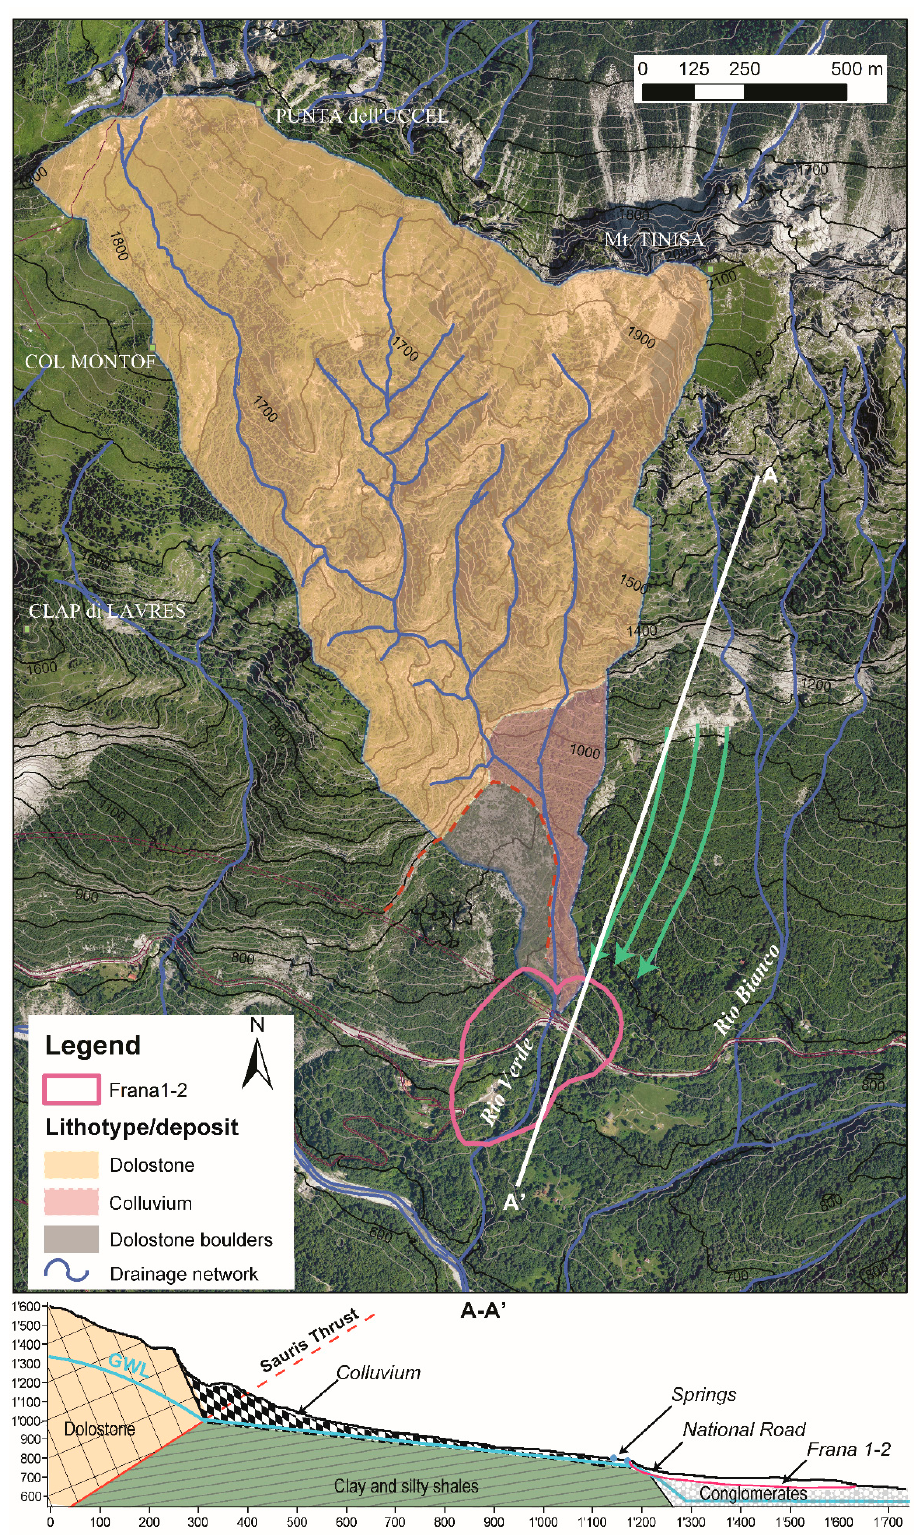
Figure 3. Lithotypes and deposits in the surface hydrological basin of the Rio Verde. The green arrows represent the groundwater flow feeding the springs. Below is a schematic hydrogeological section of the study area.